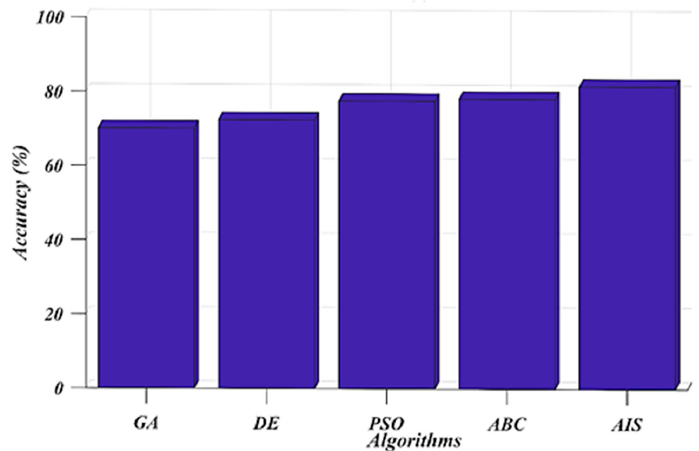
Figure 9. Accuracy Evaluation for Hepatitis.